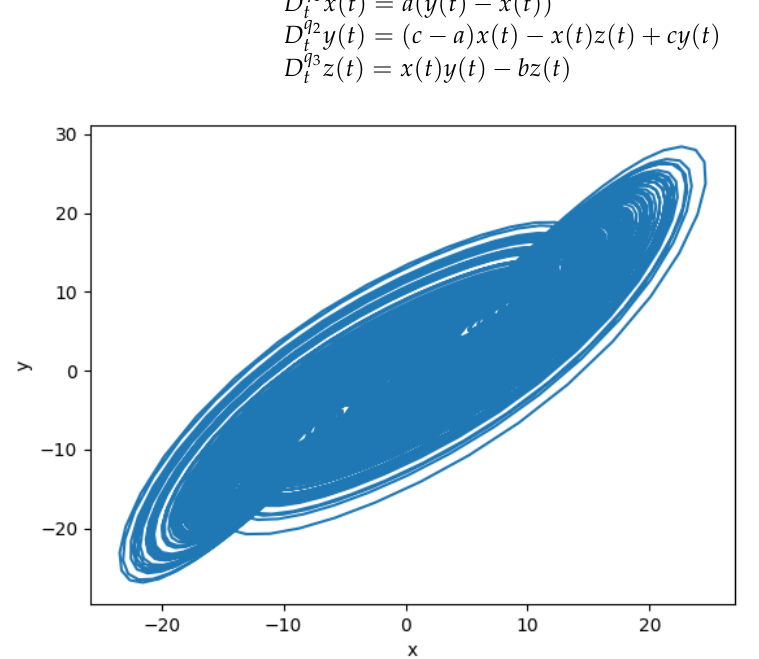
Figure 1. Chen attractor generated from (3) by setting a = 35, b = 3, c = 28, and q 1 = q 2 = q 3 = 0.9, and using initial conditions x 0 = − 9, y 0 = − 5, and z 0 = 14.